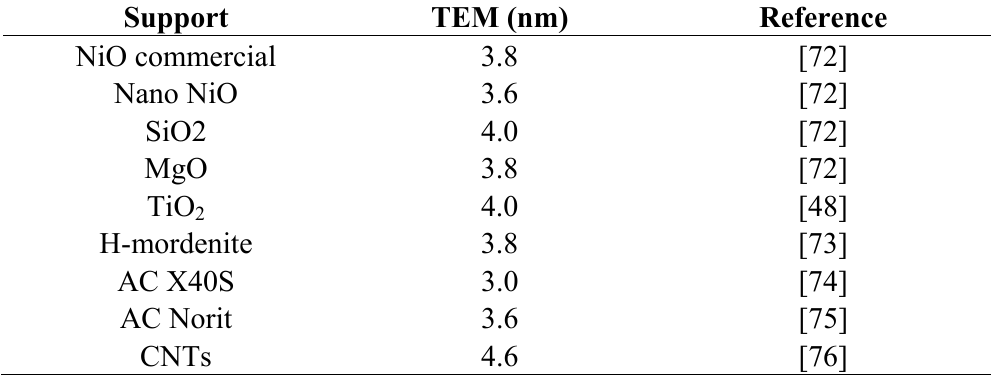
Table 1. Effect of the support on AuPVA particle size during the immobilizing